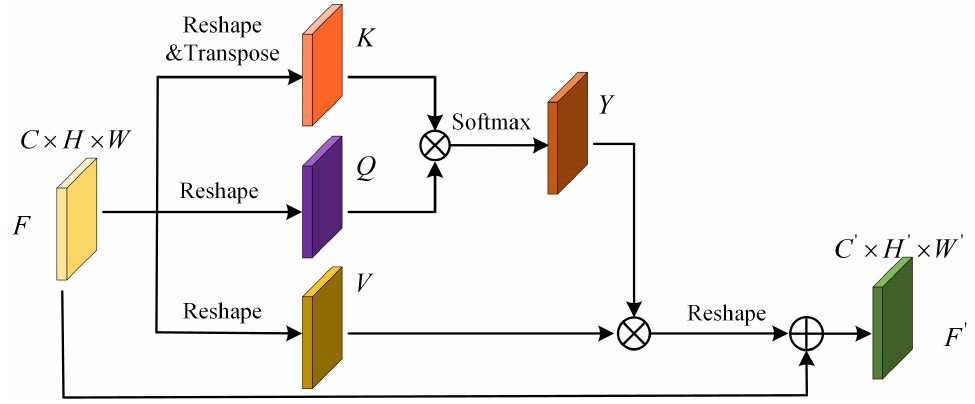
Figure 2. Flowchart of the proposed